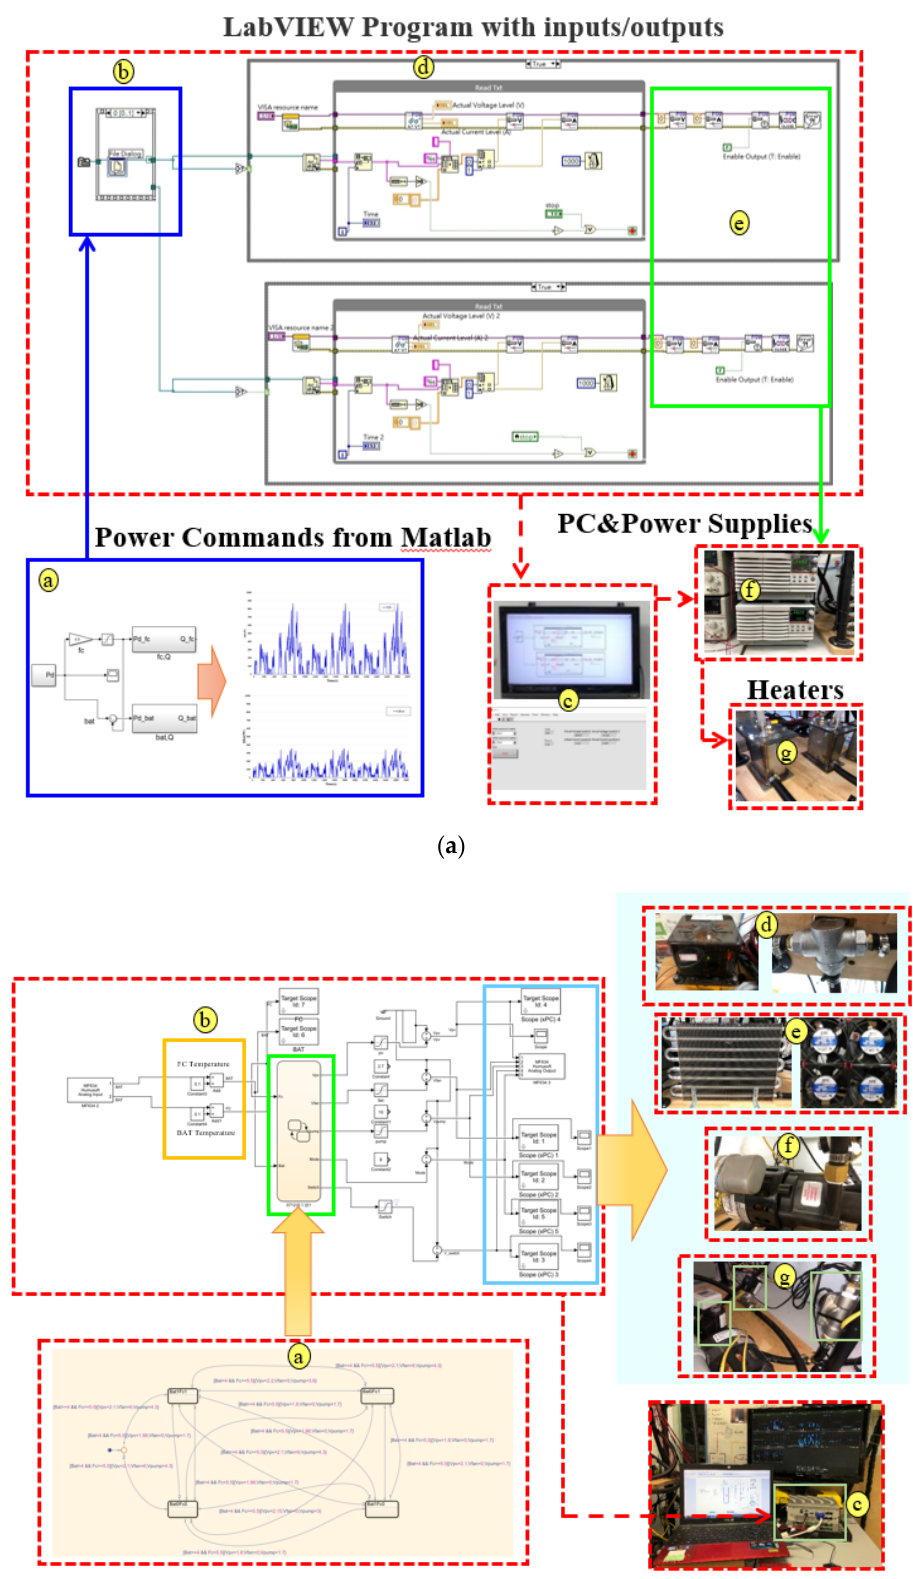
Figure 7. Control and supervision of the IHTMS: ( a ) supervisory software and ( b ) control strategy with applications.